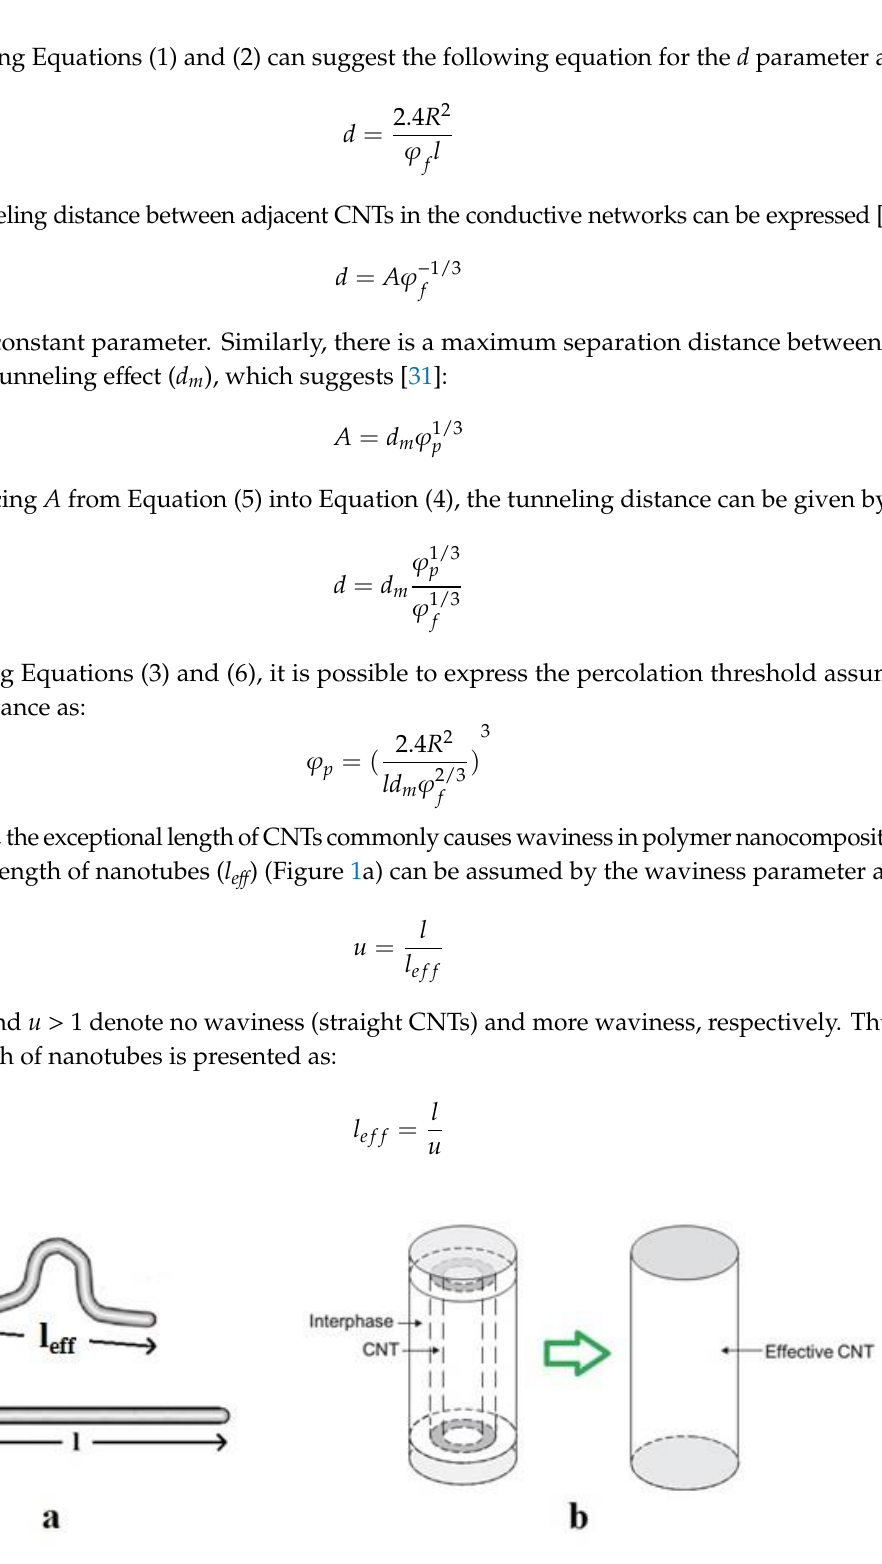
Figure 1. ( a ) Wavy and straight carbon nanotubes (CNTs), and ( b ) effective nanotube assuming an interphase (reproduced from [31], with permission from Elsevier, 2019).